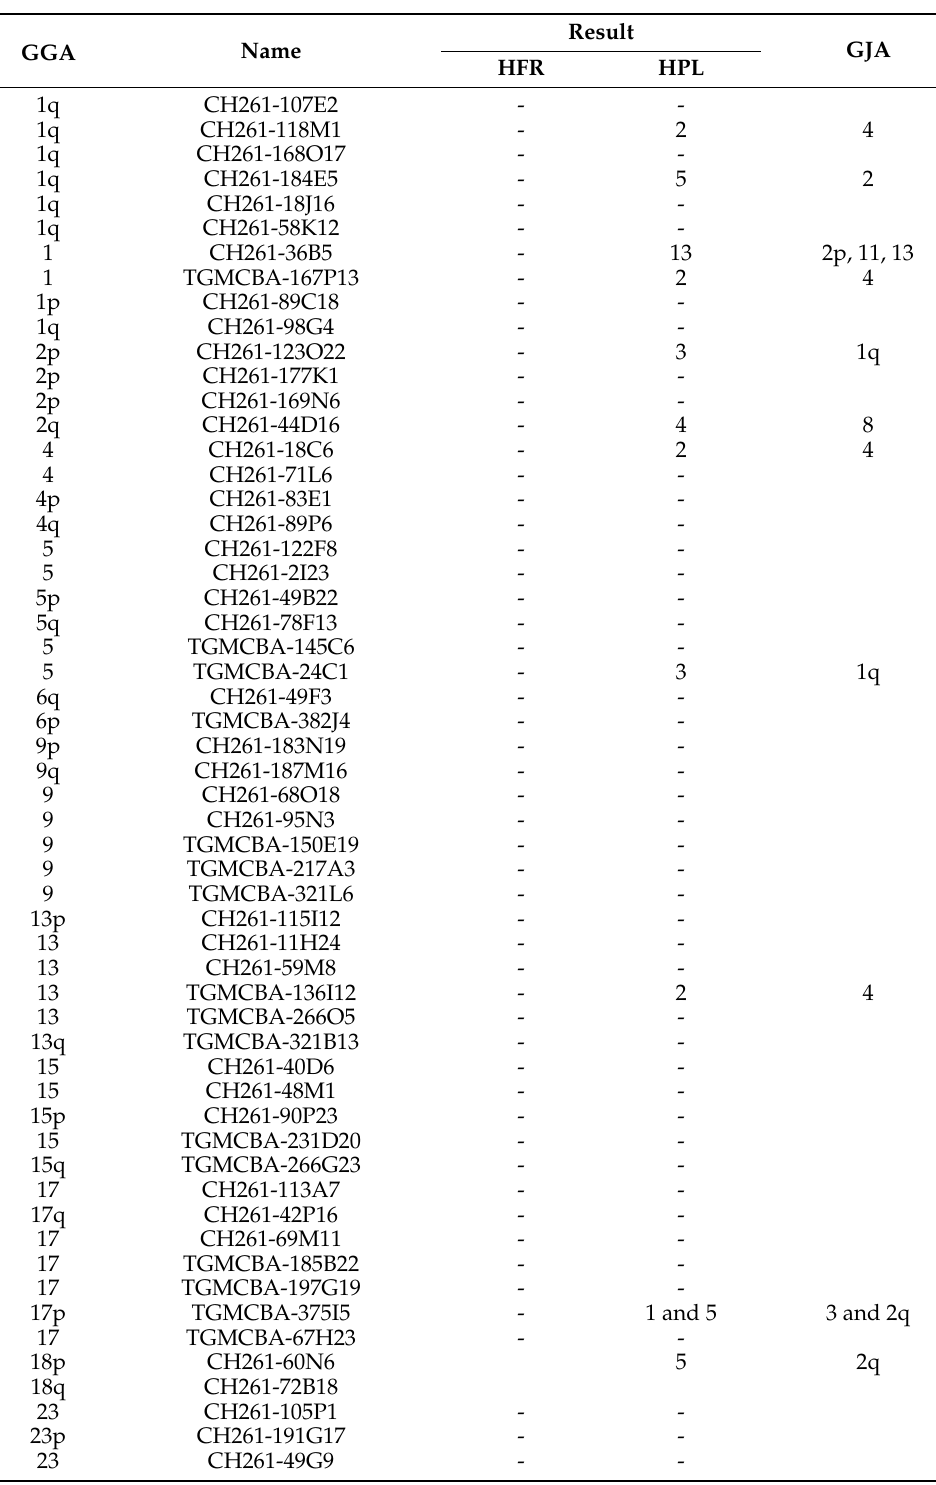
Table 2. List of chicken and zebra finch BACs mapped to common house gecko ( Hemidactylus frenatus , HFR) (Dum é ril and Bibron, 1836) [72] and flat-tailed house gecko ( Hemidactylus platyurus , HPL) (Schneider, 1797) [73] chromosomes and their chromosomal location in chicken ( Gallus gallus , GGA) (Linnaeus, 1758) [54] and Schlegel’s Japanese gecko ( Gekko japonicus , GJA) (Schlegel, 1836)